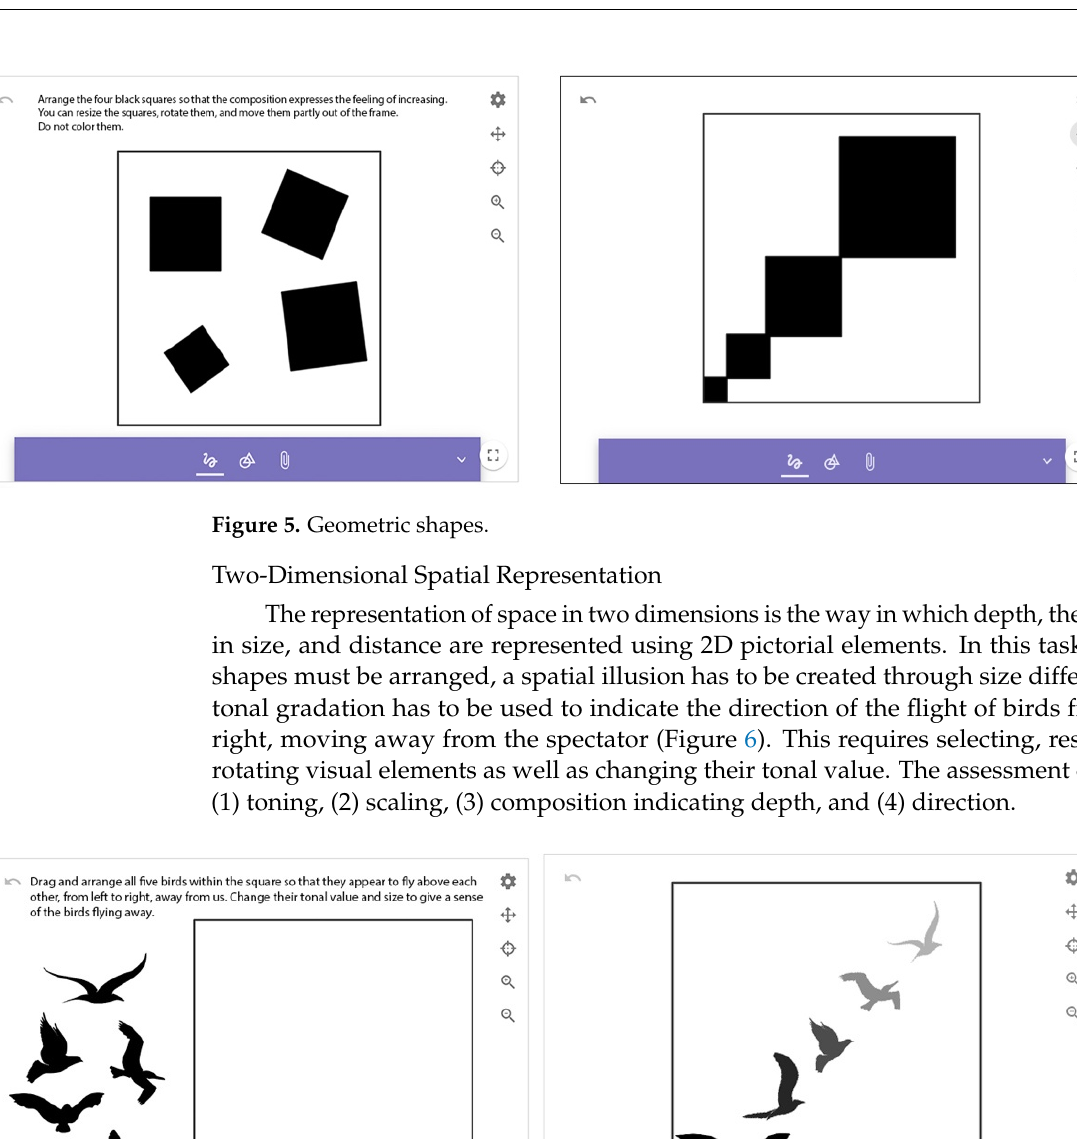
Table 3. The system of tasks and visual patterns in the test according to the primary skill elements. Subskills Image Types